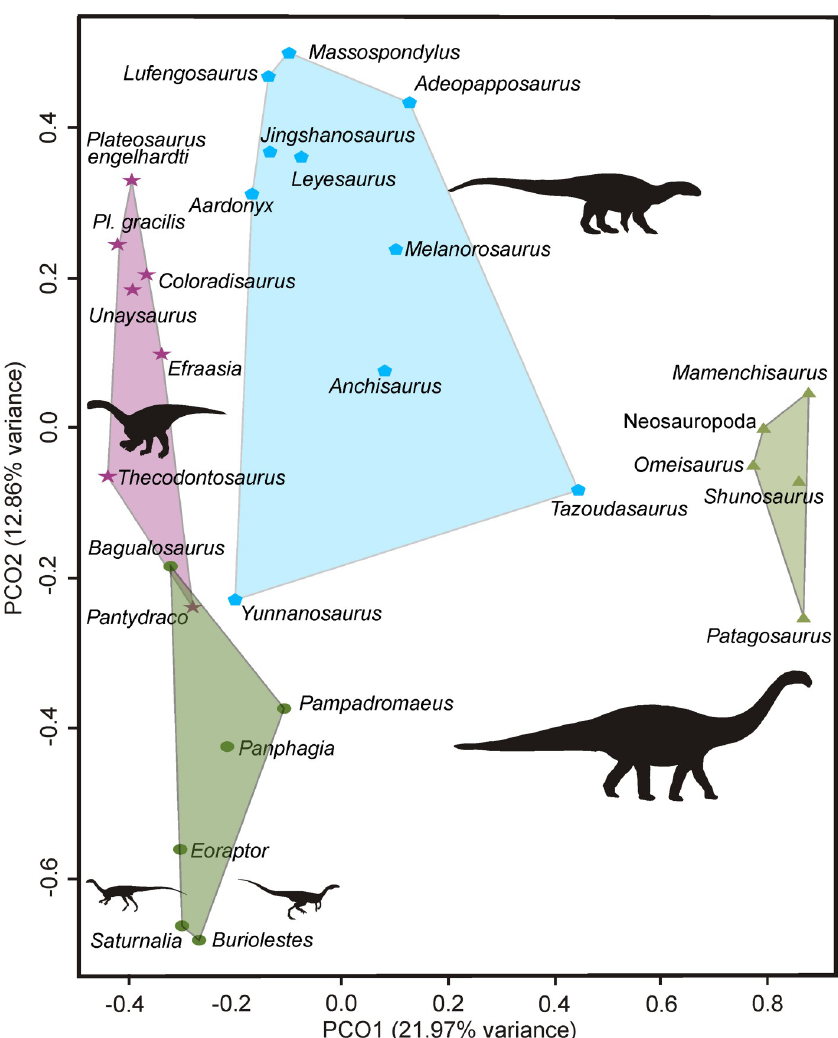
Fig 13. Results of the principal coordinate analysis based on cranial characters associated with the jaw feeding apparatus of sauropodomorphs with the variation in PCo1 plotted against PCo2. Circles, stars, pentagons, and, triangles, are assigned to taxa from the respective time intervals: Carnian (Late Triassic), Norian-Rhaetian (Late Triassic), Early Jurassic, and, Middle Jurassic.